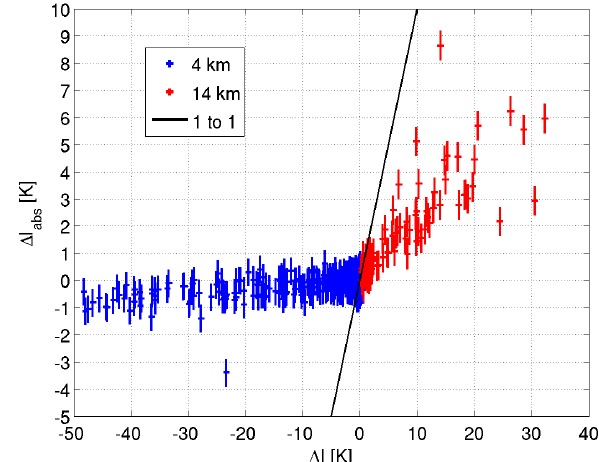
Fig. 4. The ice cloud induced change in intensity when treating the particles as purely absorbing ( ∆I abs ), as a function of ∆I for complete simulations. The ∆I abs case was achieved by setting both the scattering matrix and the scattering part of the extinction matrix to zero. The vertical lines show the uncertainty of the scattering calculations ( ± 2 σ ), originating from the Monte Carlo approach. Two tangent altitudes were considered, 4 (blue) and 14 (red) km. If scattering would have had a zero contribution, the results would have ended up around the 1 to 1 line (black). The simulations were performed for a frequency of 347.5 GHz and three dimensional tropical atmospheric data (Sec. 2.3). The particles were assumed to be horizontally aligned oblate spheroids with an aspect ratio of 2.